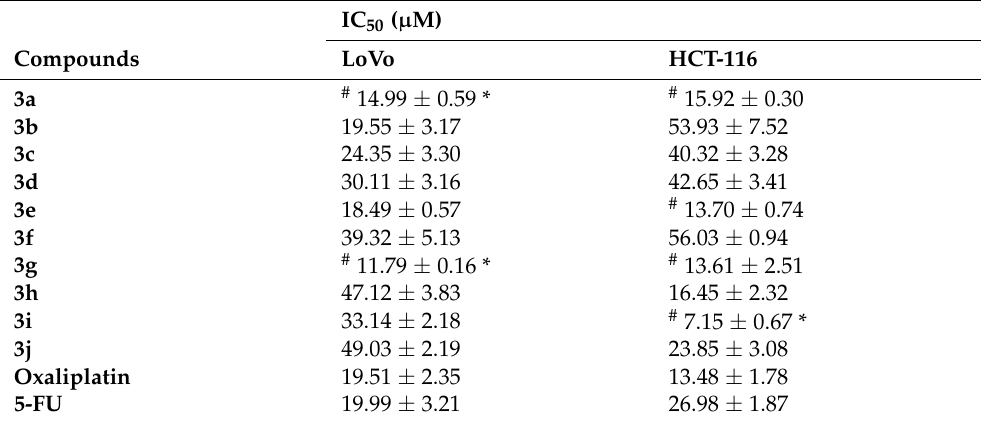
Table 2. Results of in vitro cytotoxic activity of the synthesized compounds on human-colon-cancer- cell lines (LoVo and HCT-116) a